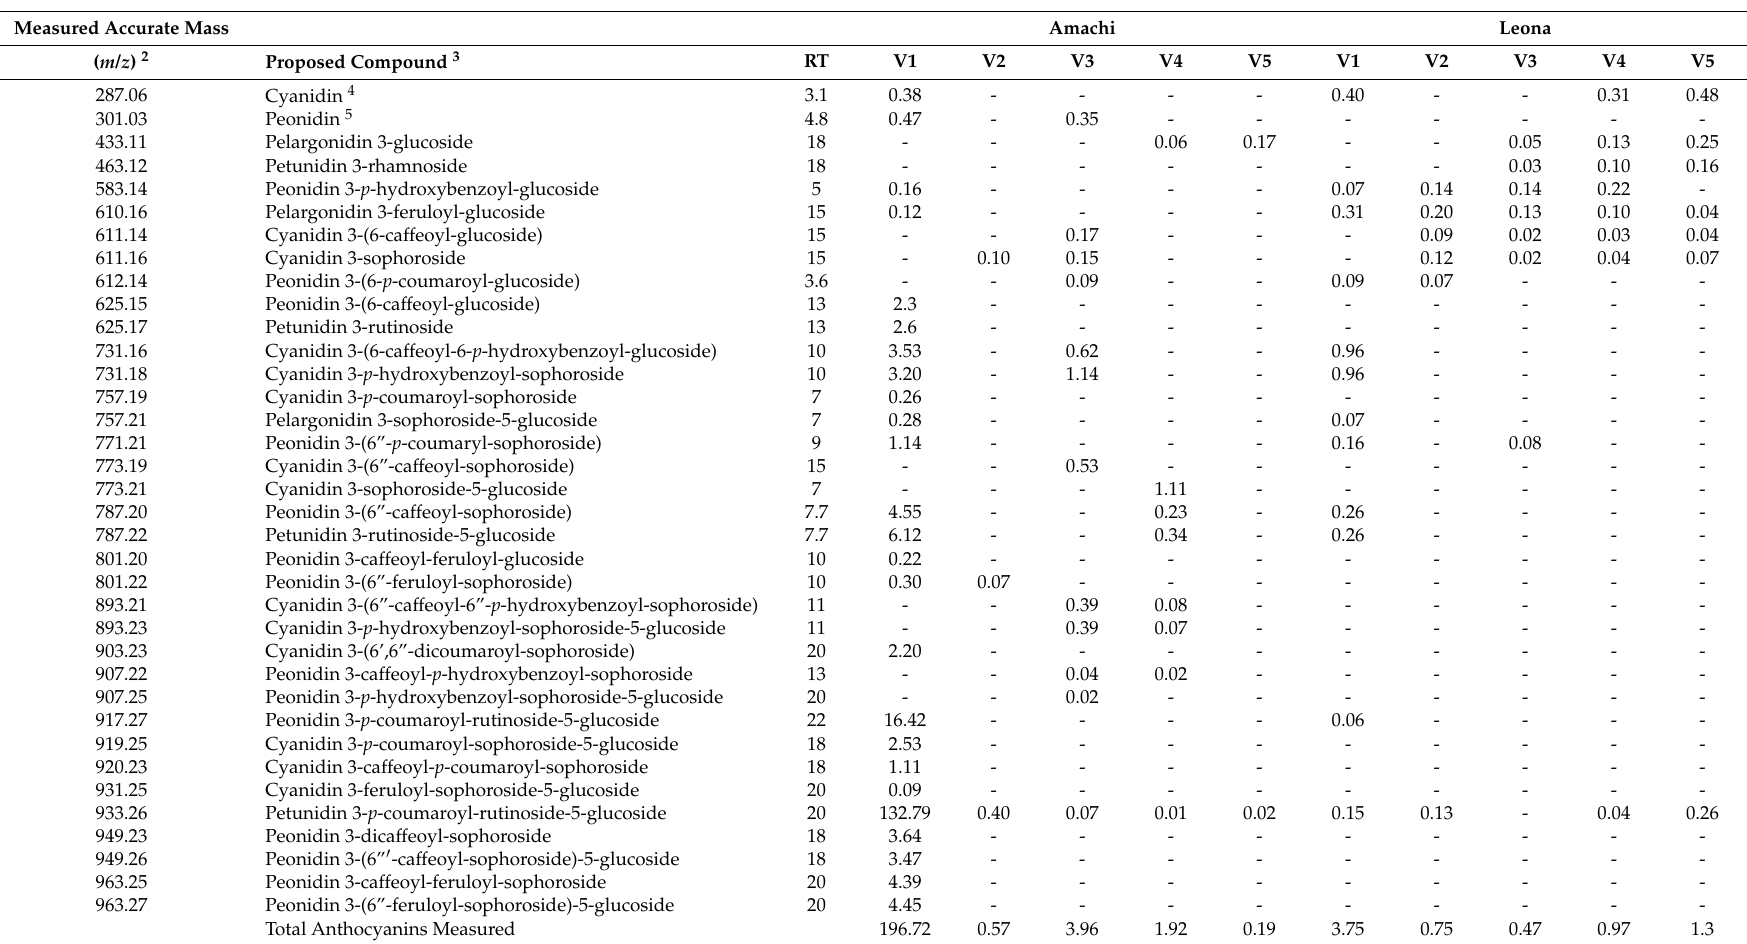
Table 1. Proposed identification of anthocyanin peaks in pigmented potato cvs. Amachi and Leona and their concentration in the samples exposed to human simulated intestinal digestion (mg/L) 1